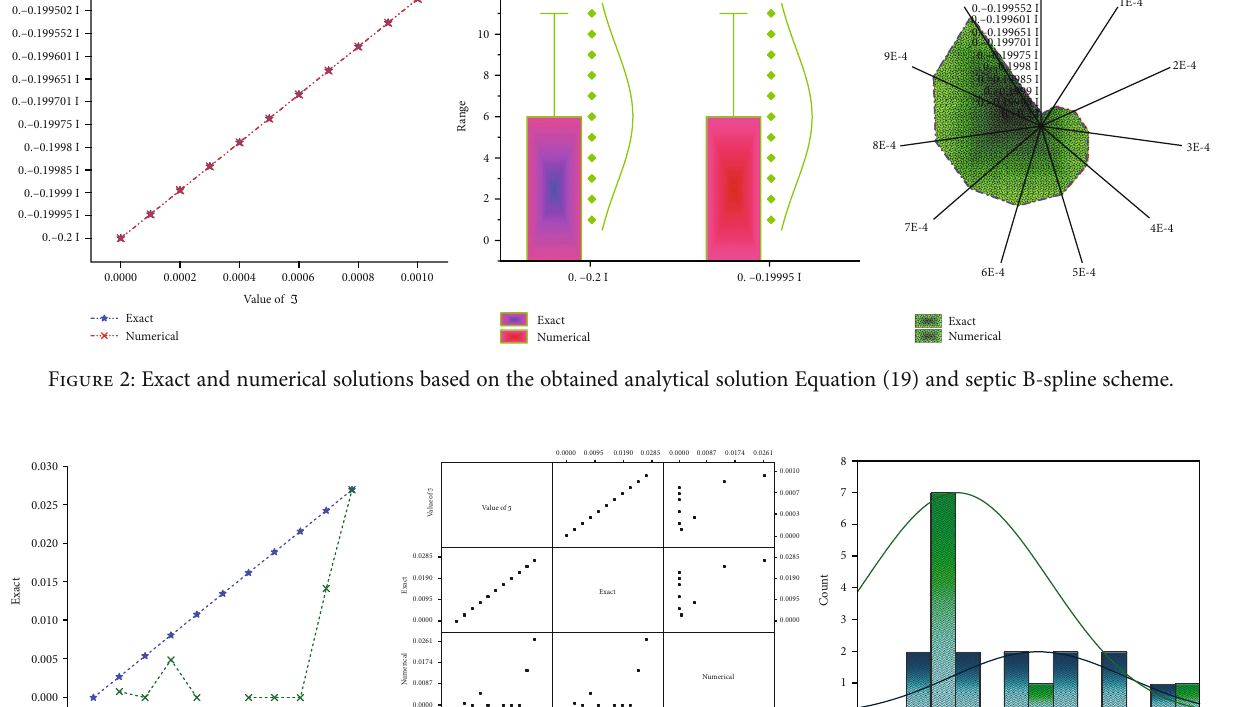
0.0000 0.0002 0.0004 0.0006 0.0008 0.0010 Exact Figure 3: Exact and numerical solutions based on the obtained analytical solution Equation (20) and septic B-spline